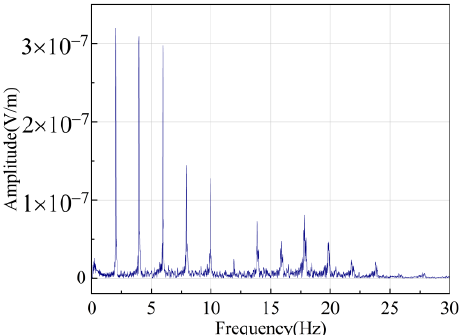
Figure 15. Frequency domain diagram of the experimental shaft-rate electric field.